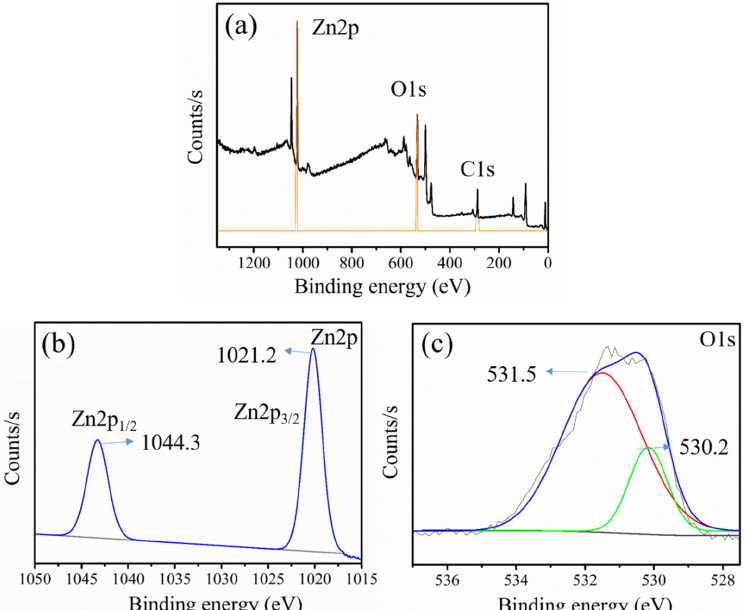
Figure 6. X-ray photoelectron spectroscopy (XPS) analysis of the GL–CMC–ZnO NCs: ( a ) full survey spectrum; ( b ) Zn2p binding energy region; ( c ) O1s binding area.